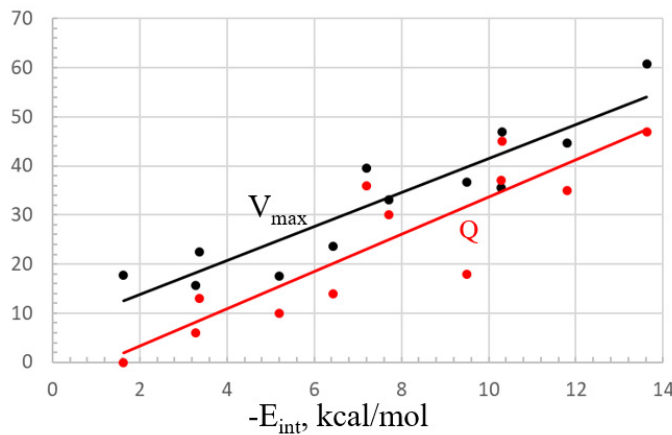
Figure 7. Linear fitting of the interaction energy to the MEP maximum (kcal/mol, black) and total charge transfer Q (red, me).